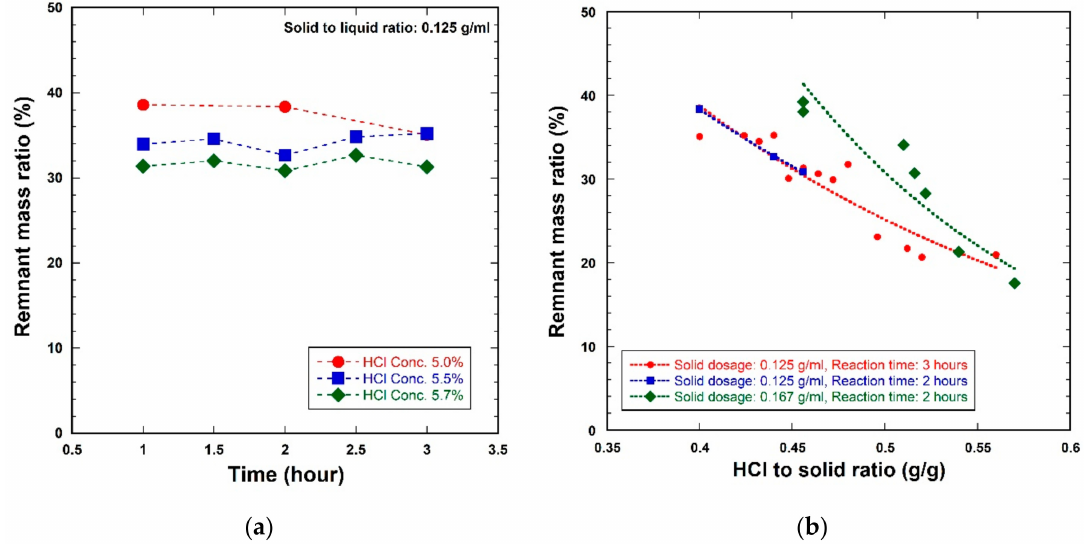
Figure 4. Remnant mass ratio ( a ) as a function of reaction time with the 5.0%, 5.5%, and 5.7% HCl solutions (solid to liquid ratio: 0.125 g/mL and ( b ) as a function of HCl to solid ratio with reaction times of 2 and 3 hours (dotted lines: trend line of remnant mass ratio as a function of HCl to solid